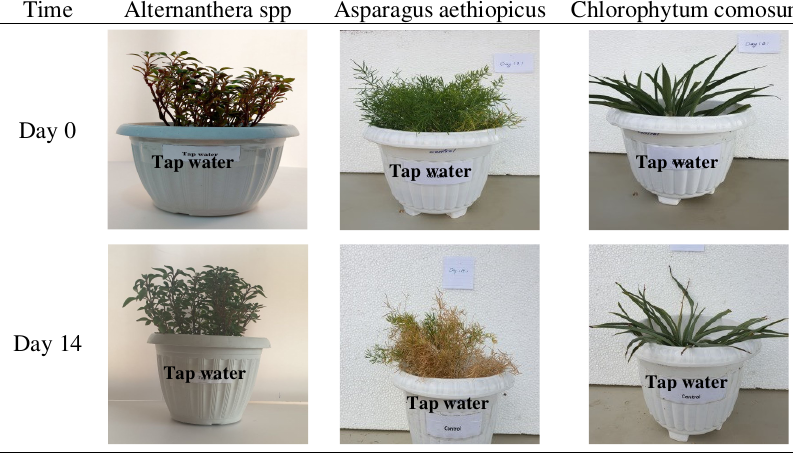
The physical appearance of selected plants in control systems